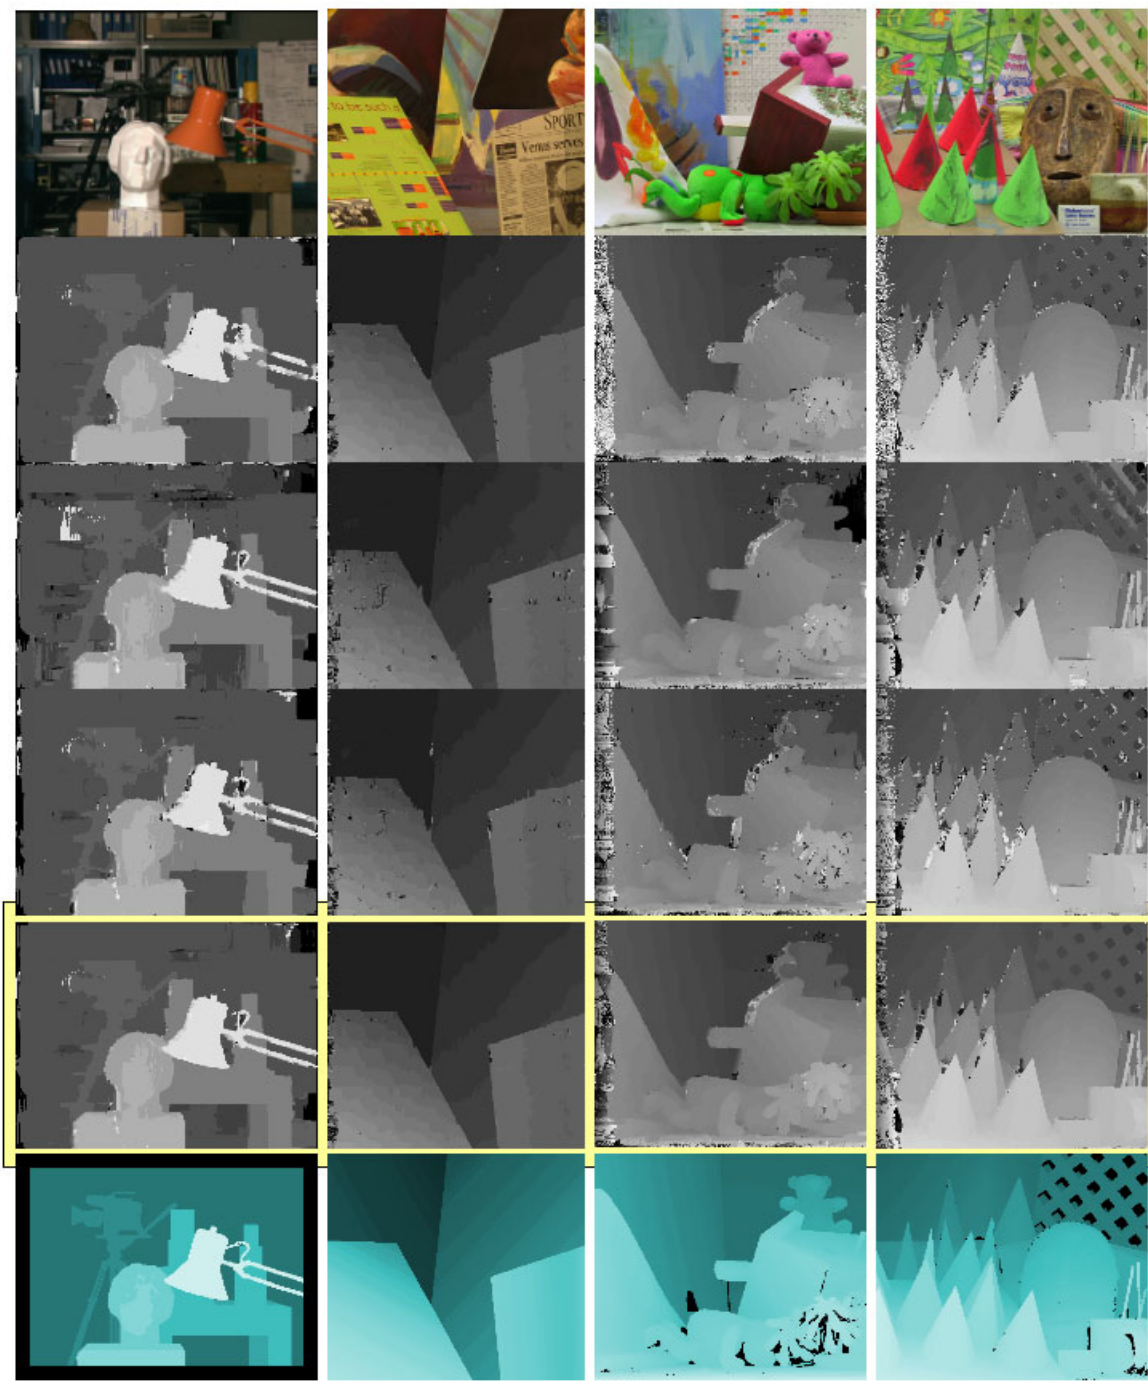
Figure 4. Comparison of different matching cost functions for four Middlebury stereo pairs. Disparity maps are presented from individual and the overall matching function after the aggregation step. Top to bottom : left image; proposed modified census trans- formation; AD on image channels; AD in principal images gradients; combined cost; and reference disparity maps. The refinement steps described in section 5 have not been used here, in order to illustrate individual results and the improvement achieved by fusing the three